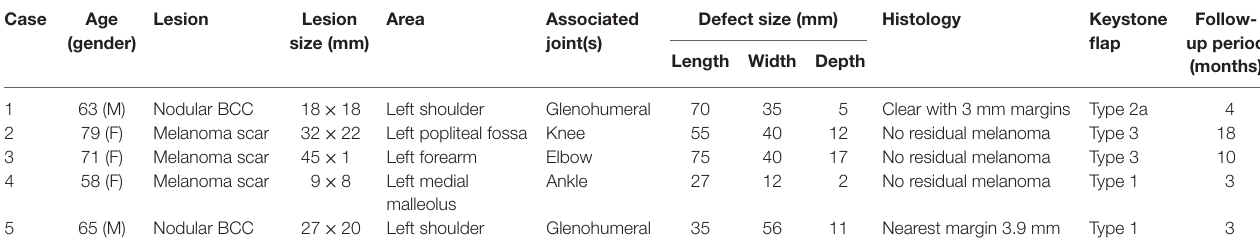
table 1 | Summary of lesion type, size, post-excision defect size, keystone flap subtype, and postoperative complications for included